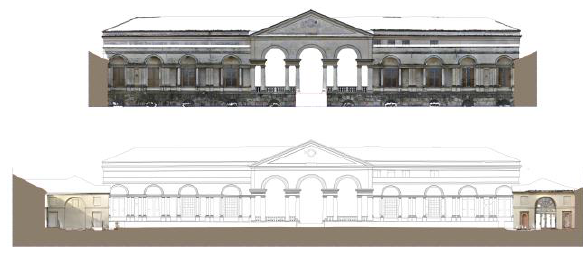
Figure 16. East façade frontage representations.